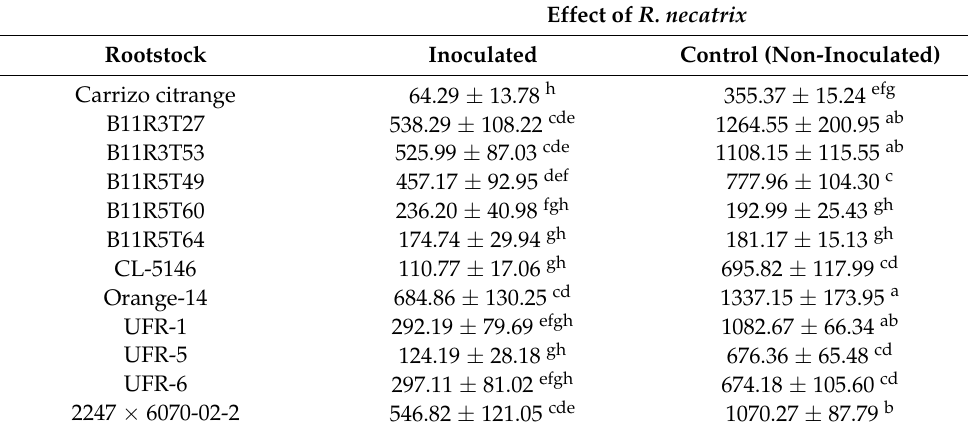
Table 2. Mean leaf area response (cm 2 ) ± standard error (SE), due to the effect of R. necatrix (inoculated and non-inoculated), in 12 citrus rootstocks (Carrizo citrange, B11R3T27, B11R3T53, B11R5T49, B11R5T60, B11R5T64, CL-5146, Orange-14, UFR-1, UFR-5, UFR-6 and 2247 × 6070-02-2). Effect of R. necatrix Rootstock Inoculated Control